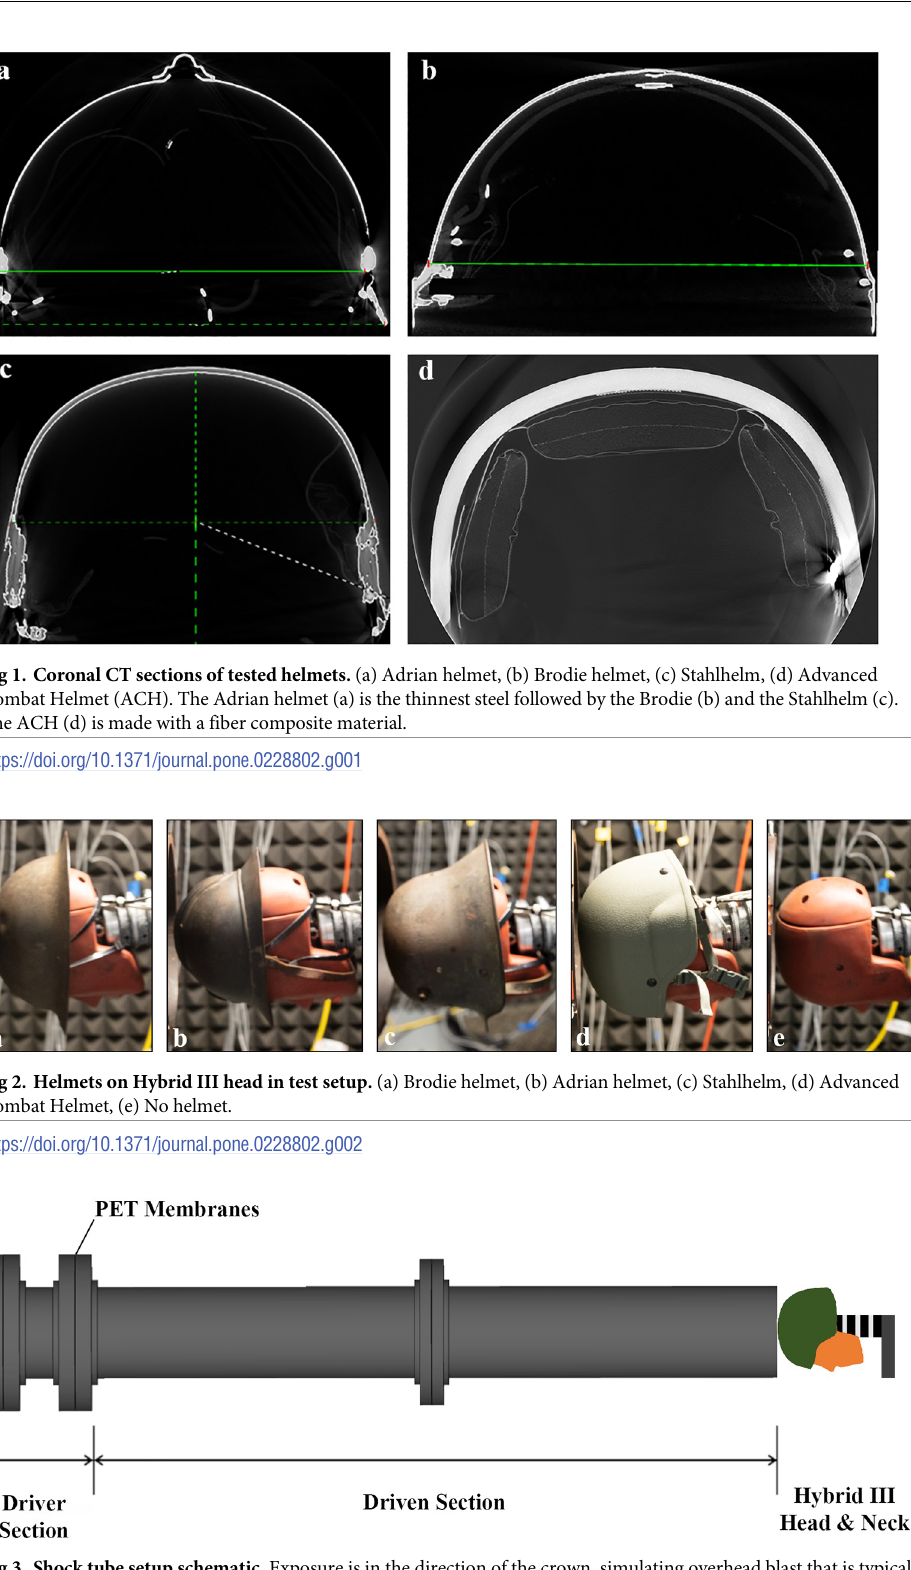
Fig 3. Shock tube setup schematic. Exposure is in the direction of the crown, simulating overhead blast that is typical exposure for personnel in trenches or prone on the